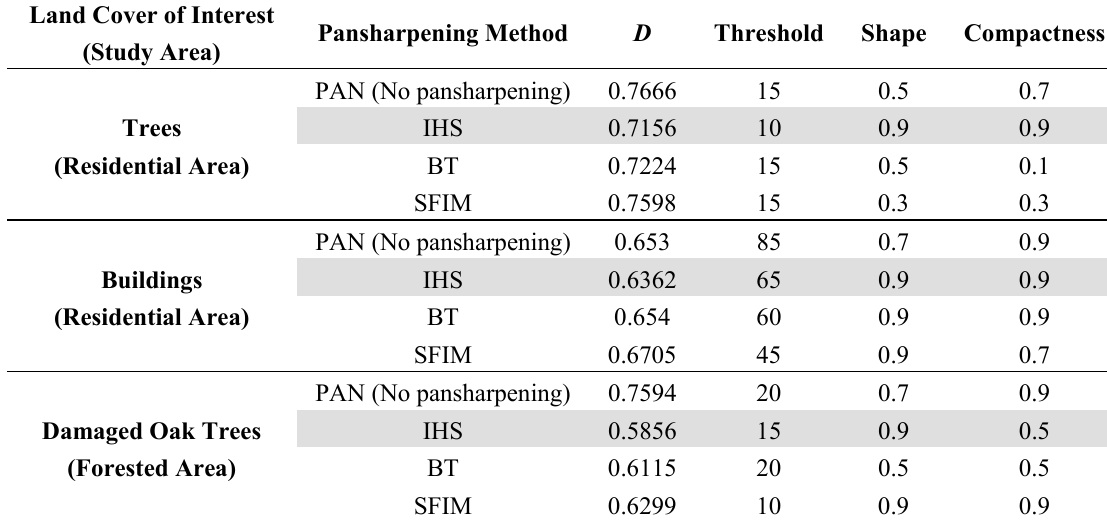
Table 1. D Metric values ( D ) of the most spatially-accurate segmentations ( i.e. , those with the lowest D value) for each pansharpening method, and the Threshold, Shape, and Compactness parameters that produced these segmentations. Lower D indicates a more spatially-accurate segmentation. The pansharpening method with the most accurate segmentation for each land cover of interest is highlighted in